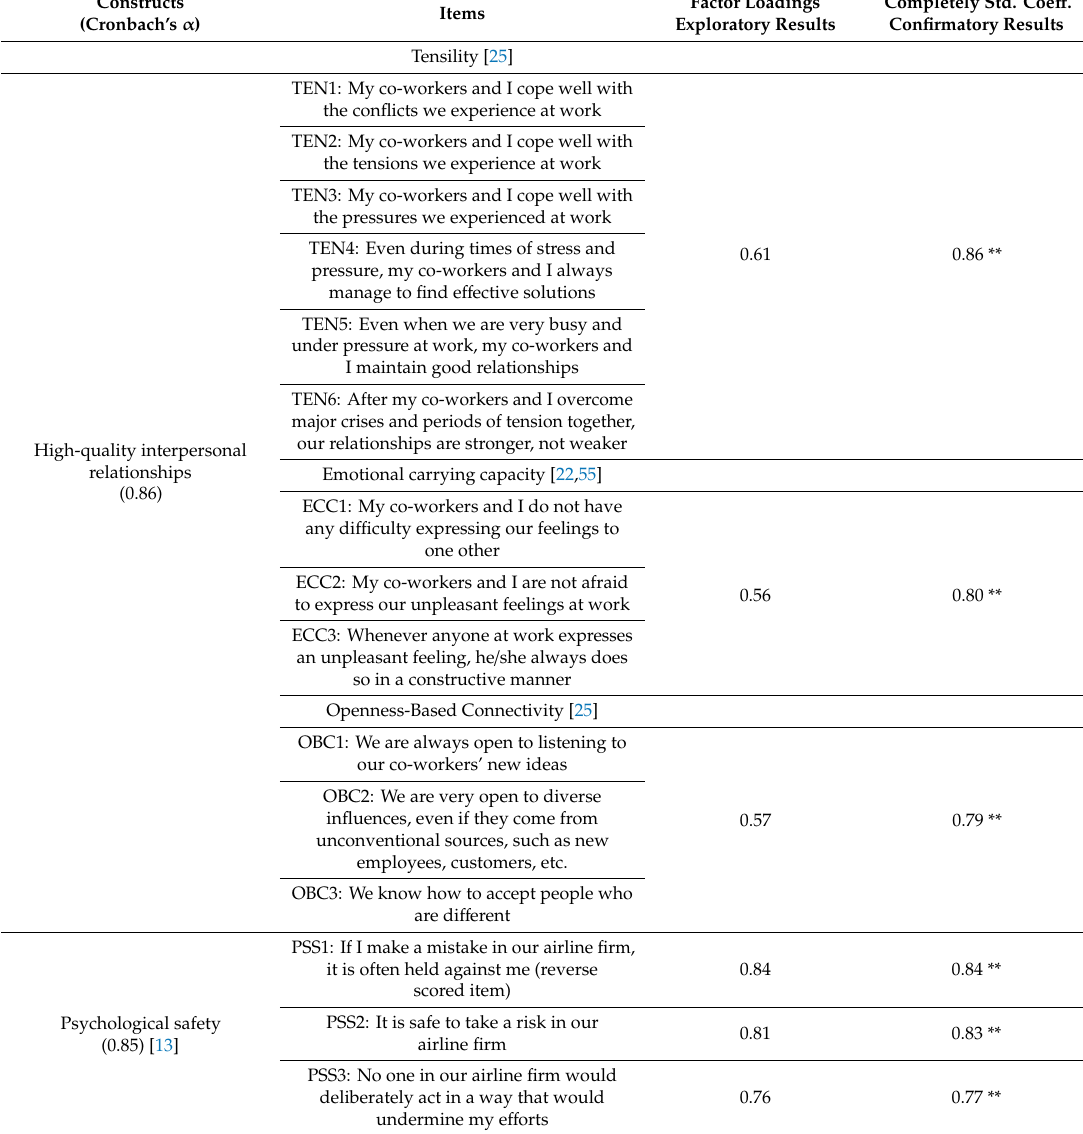
Table 3. The exploratory and confirmatory factor analyses of salient